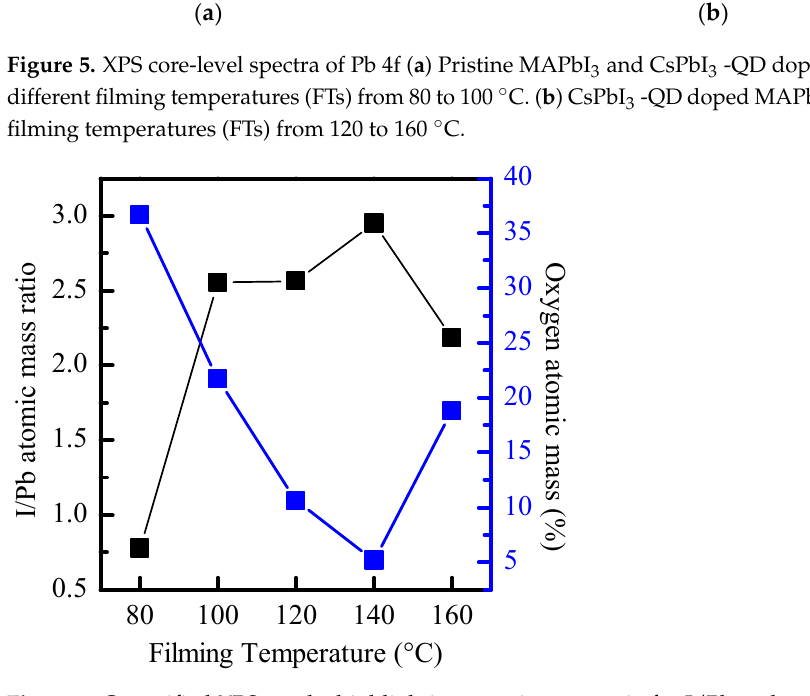
Figure 6. Quantified XPS results highlighting atomic mass ratio for I/Pb and oxygen atomic mass percentage for different filming temperatures.